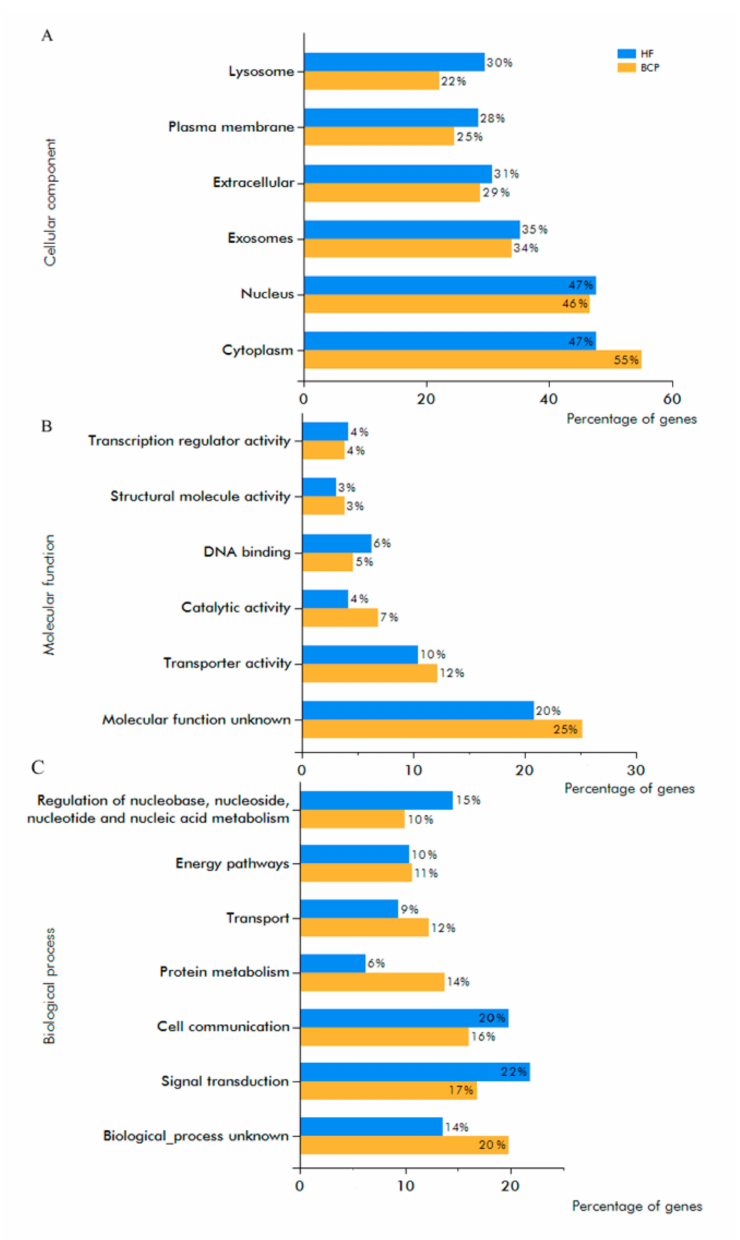
Figure 5. GO analysis of exosomal proteins from HF and BCP blood. Proteins were classified by cellular component ( A ), molecular function ( B ) and biological processes ( C